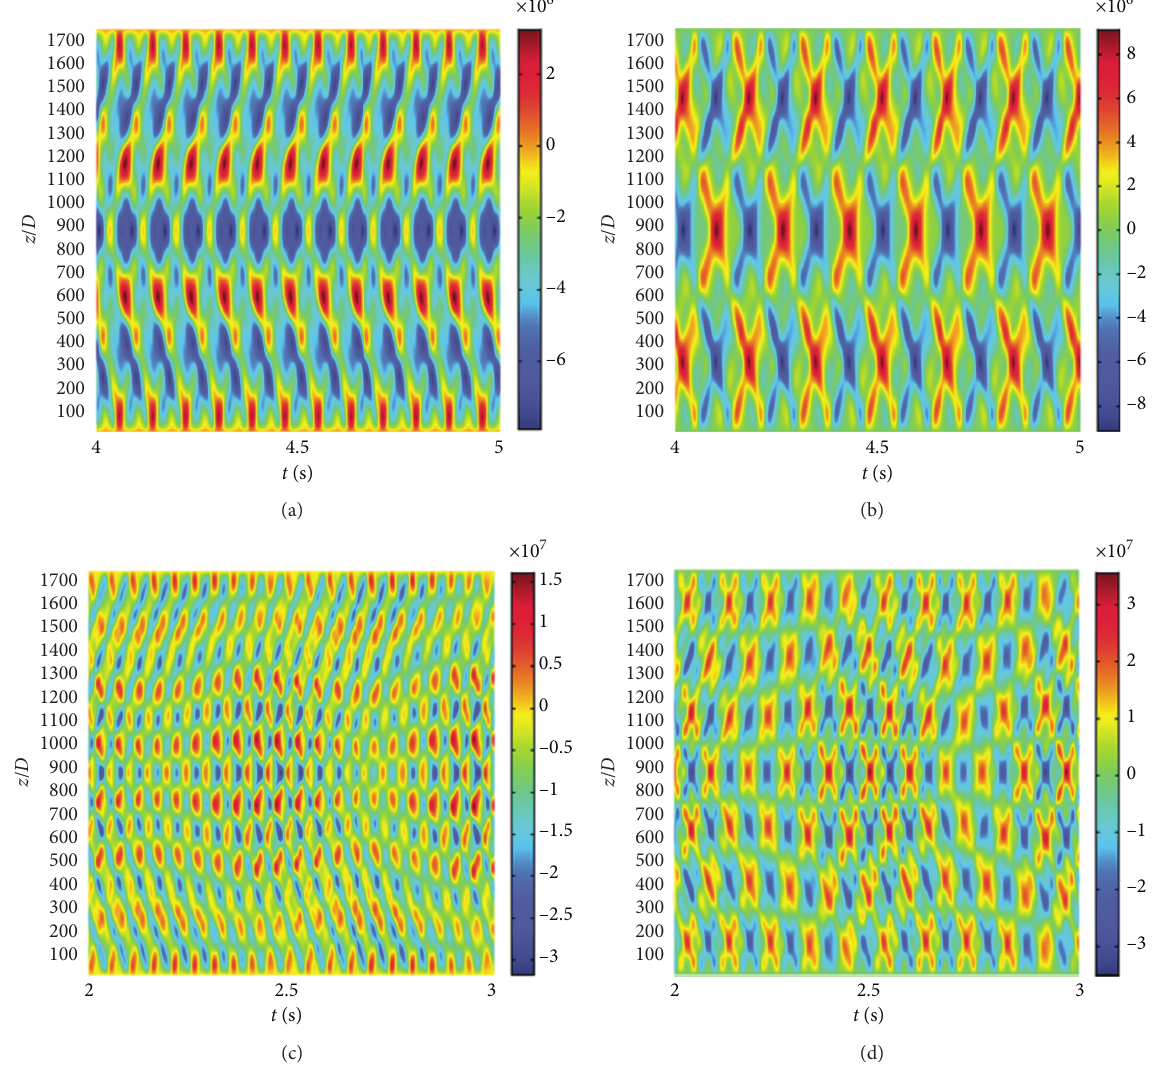
Figure 5: The effects of different sea water velocities on the stress of the marine riser. (a) The in-line and (b) cross-flow with U � 0 . 3m/s. (c) The in-line and (d) cross-flow with U � 0.8